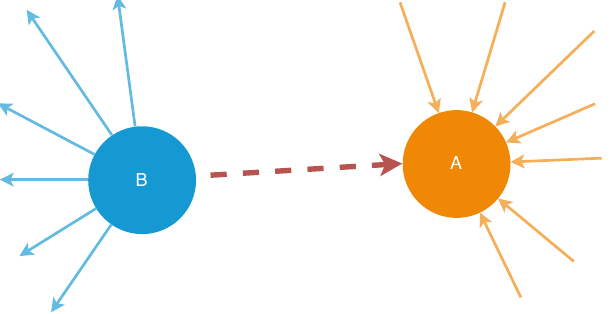
Figure 2. Differentiation of CR and RR metrics in time snapshot: CR considers in denominator all B citations including citation to A (blue arrows and red arrow), whereas RR denominator considers all citations to A (orange arrows and red